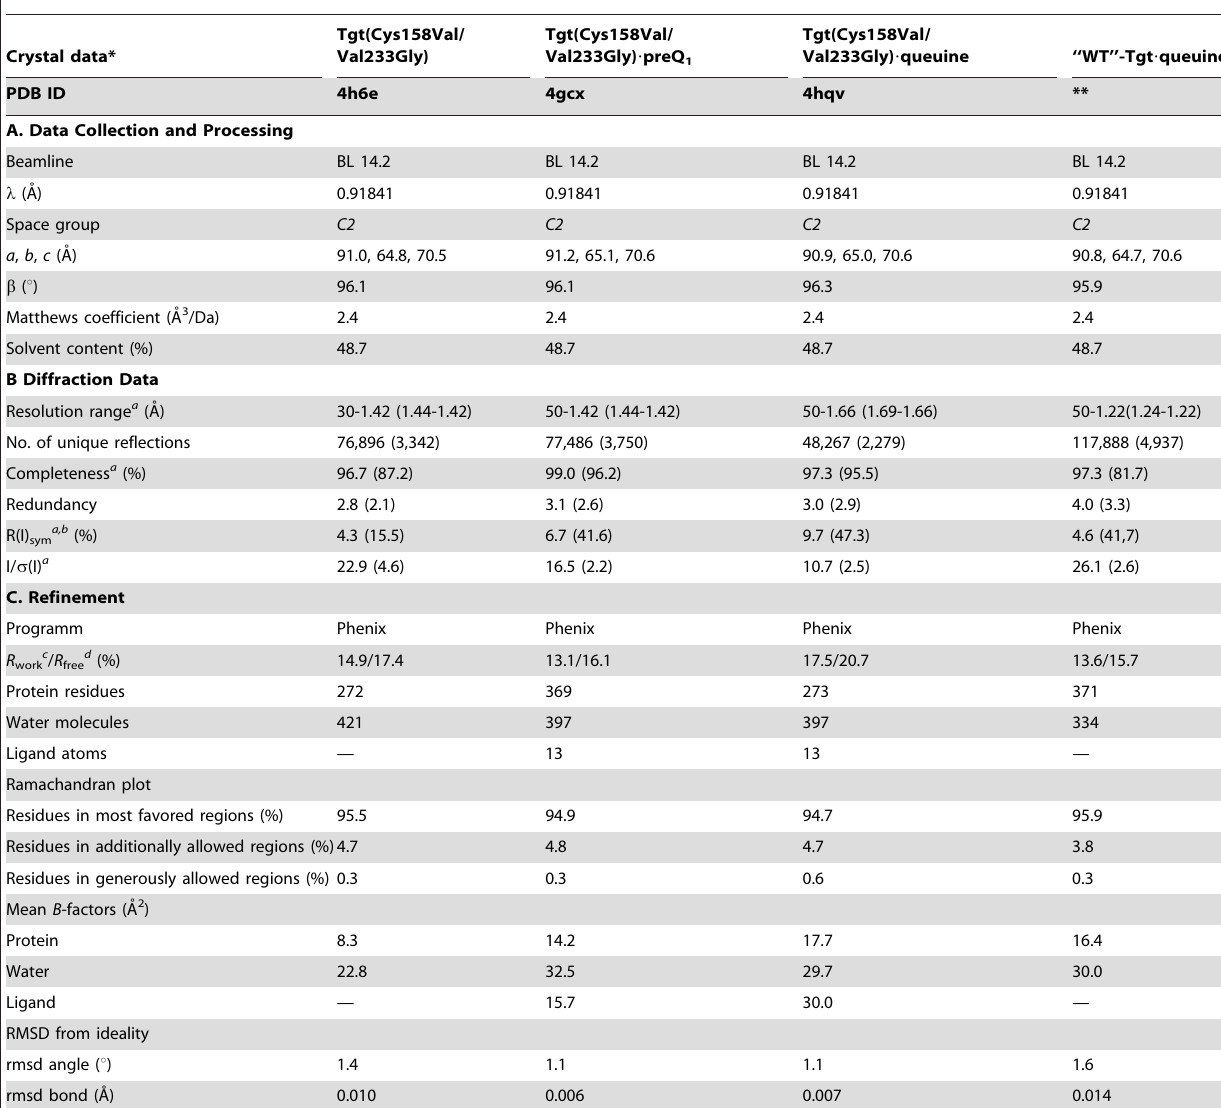
Table 4. Crystallographic data collection and refinement statistics – Tgt(Cys158Val/Val233Gly),